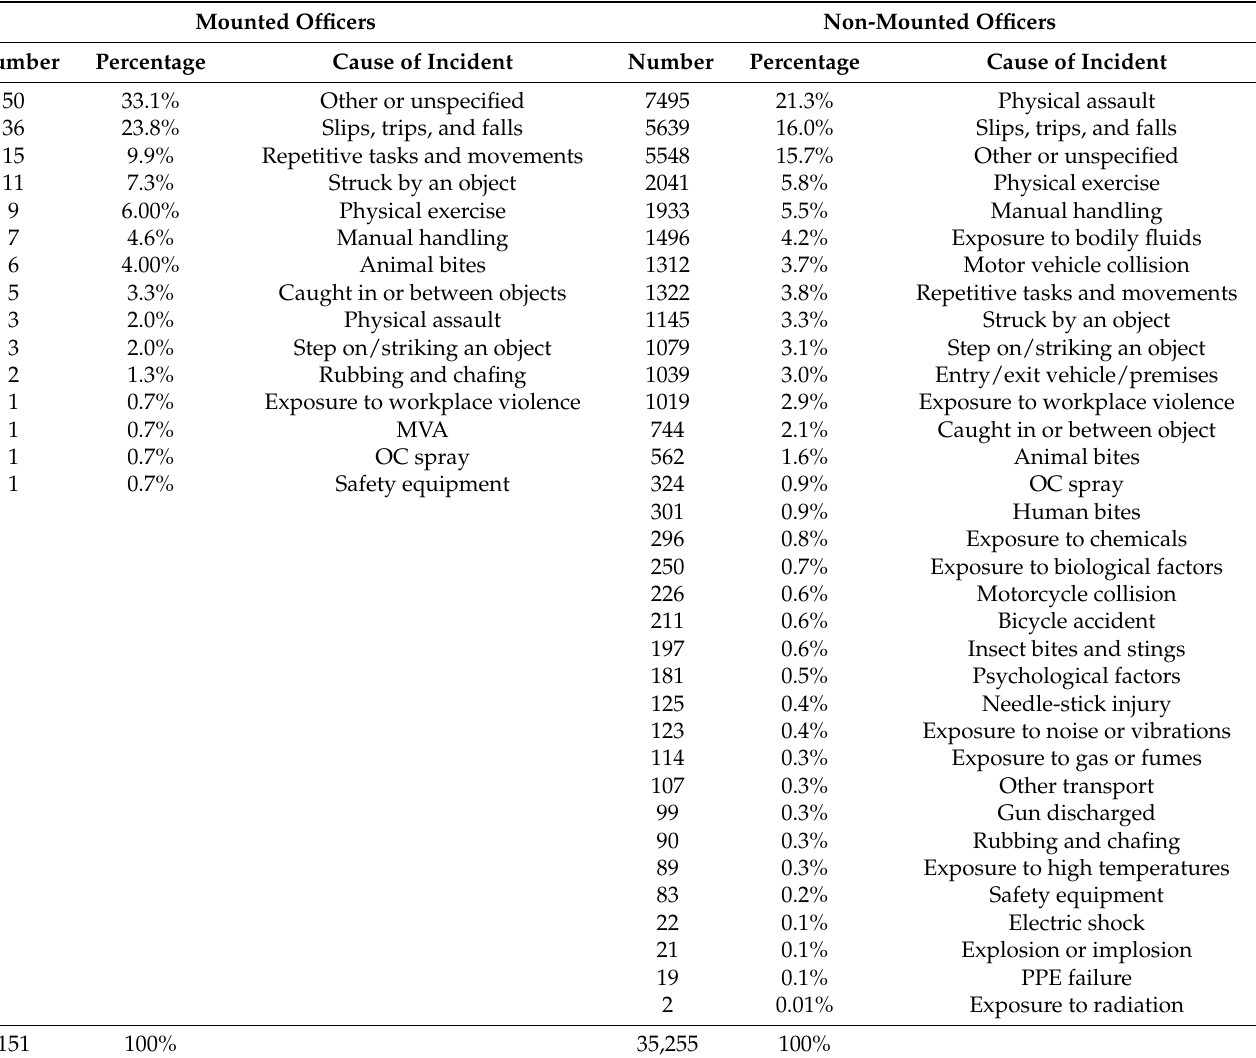
Table 3. Injuries by reported cause of the